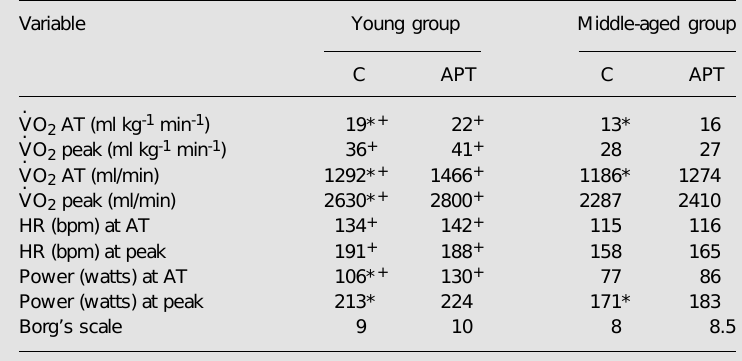
Data are reported as medians. Young group, N = 10; middle-aged group, N = 7. AT, anaerobic threshold; HR, heart rate.